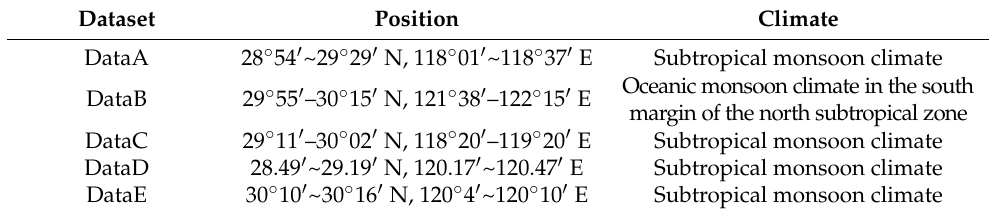
Table 1. Experimental data